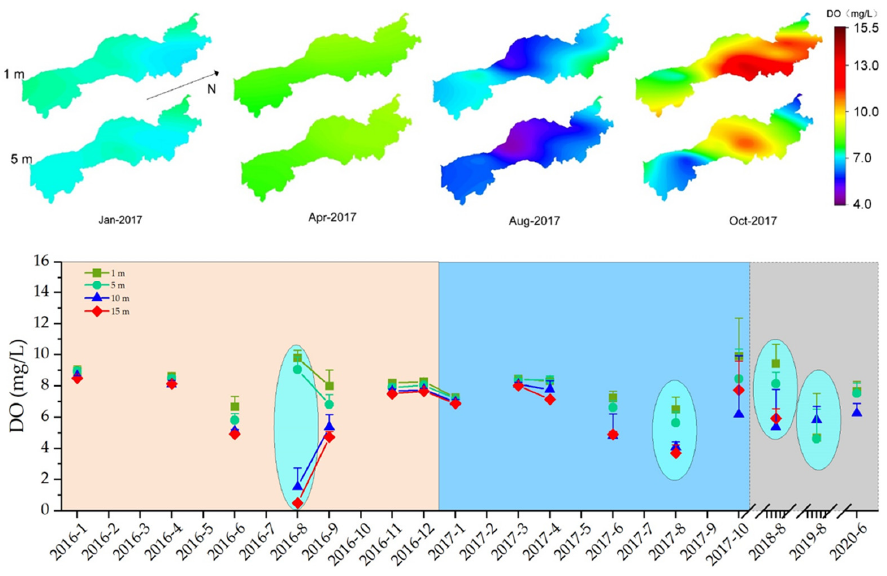
Figure 5. Spatiotemporal changes in DO.